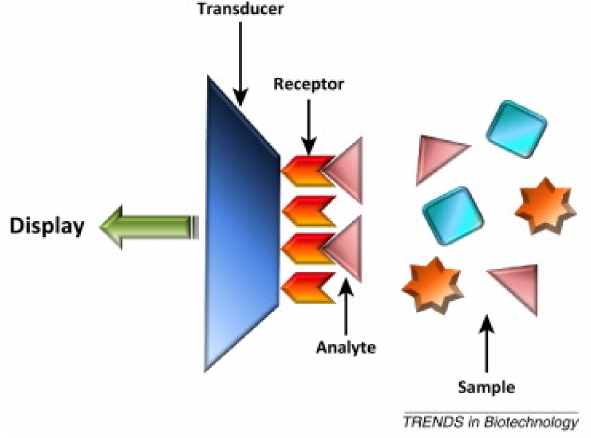
Figure 2. A scheme of a typical chemosensor. Reprinted with the permission from reference [17]. Copyright 2014